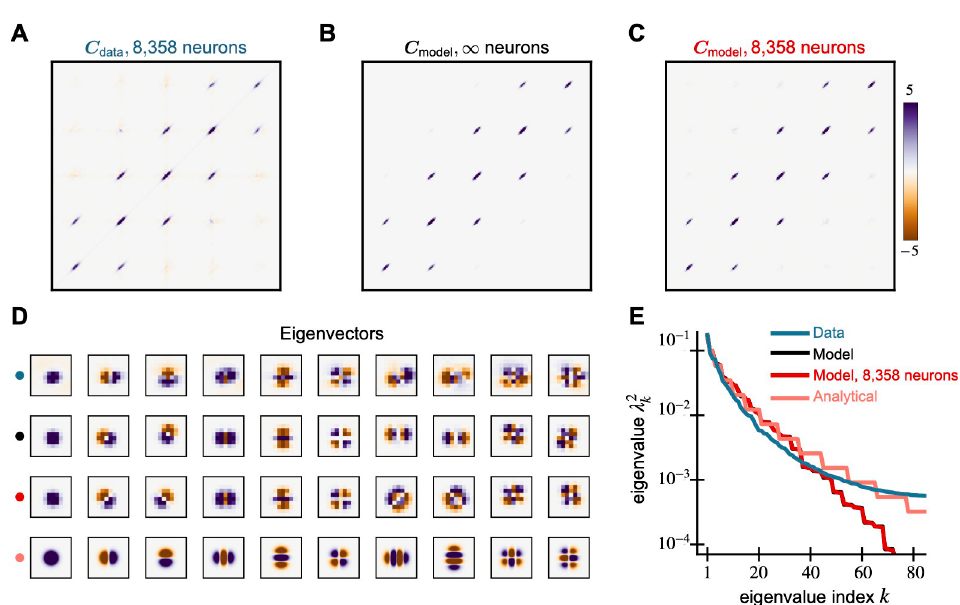
Fig 5. Spectral properties of V1 RFs and our model are similar. We compare the covariance matrices generated from the (A) receptive fields of 8,358 mouse V1 neurons, (B) the GP model Eq (9), and (C) 8,358 random samples from the model. These resemble a tri-diagonal matrix whose diagonals are non-zero at equally-spaced segments. (D) The leading 10 eigenvectors of the data and model covariance matrices show similar structure and explain 68% of the variance in the data. Analytical Hermite wavelet eigenfunctions are in the last row and differ from the model due to discretization (both cases) and finite sampling (8,358 neurons only). (E) The eigenspectrum of the model matches well with the data. The staircase pattern in the model comes from repeated eigenvalues at each frequency. The model curve with infinite neurons (black) is obscured by the model curve with 8,358 neurons (red).